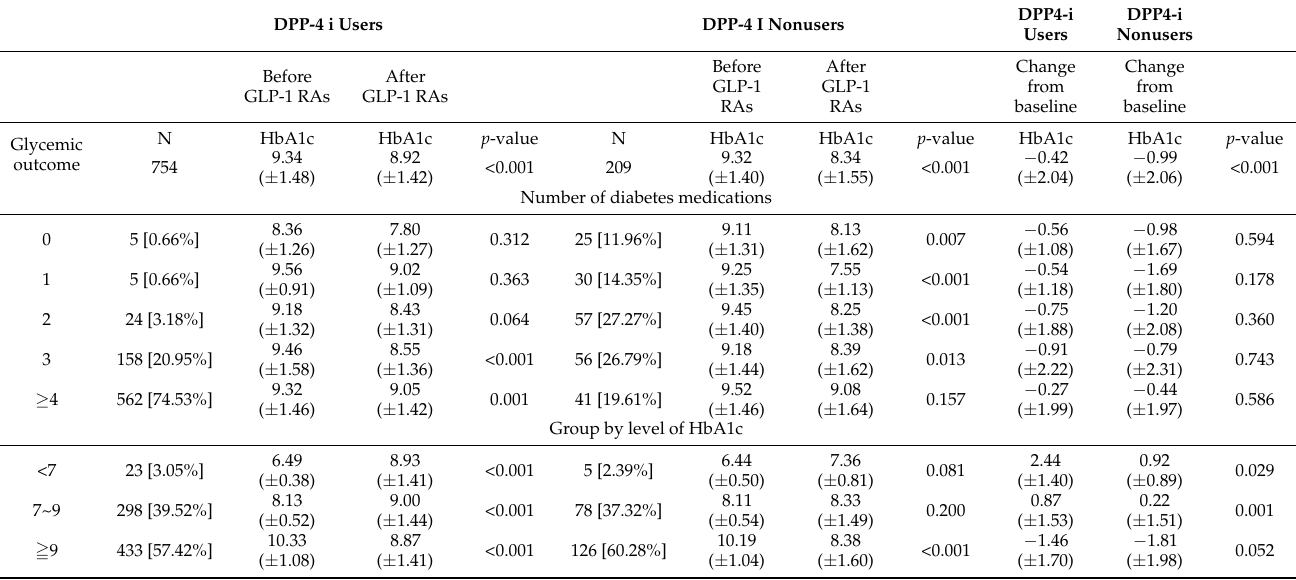
Table 2. Changes in HbA1c by treatment group. Data are mean ±